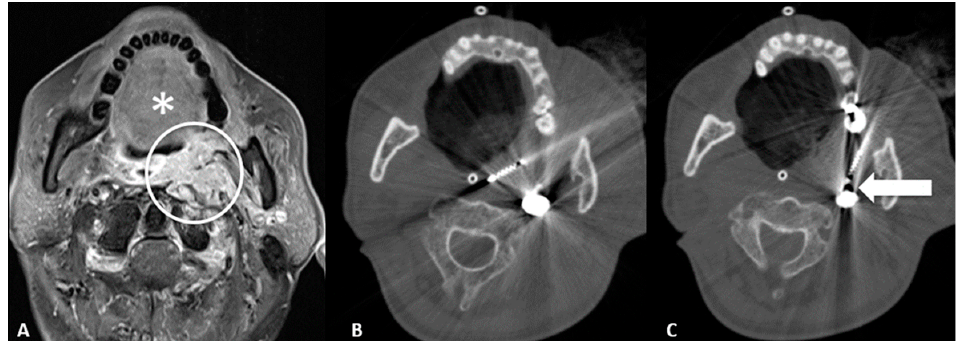
Figure 2. 65-year-old male with trismus, gagging, airway compromise, and bleeding episodes due to recurrent nasopharyngeal carcinoma of the left retropharyngeal/paravertebral space with cir- cumferential carotid artery involvement, after previous radiation therapy and left neck dissection. ( A ) T1-weighted postcontrast axial MRI scan showing malignant involvement of the left retropharyn- geal space (circle). Notice the tongue (*) which can flop backward during the general anesthesia and could contact the ablation site; care must be taken in blocking the tongue prior to ablation. ( B ) Axial CT scan showing cryoablation needle placement through the retromolar trigone. ( C ) Axial CT scan showing the cryoablation needle near the previously embolized left carotid artery (arrow), which can lead to diving